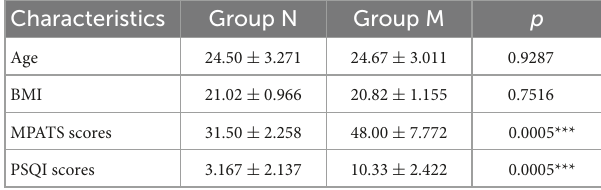
TABLE 1 Essential characteristics of the recruited